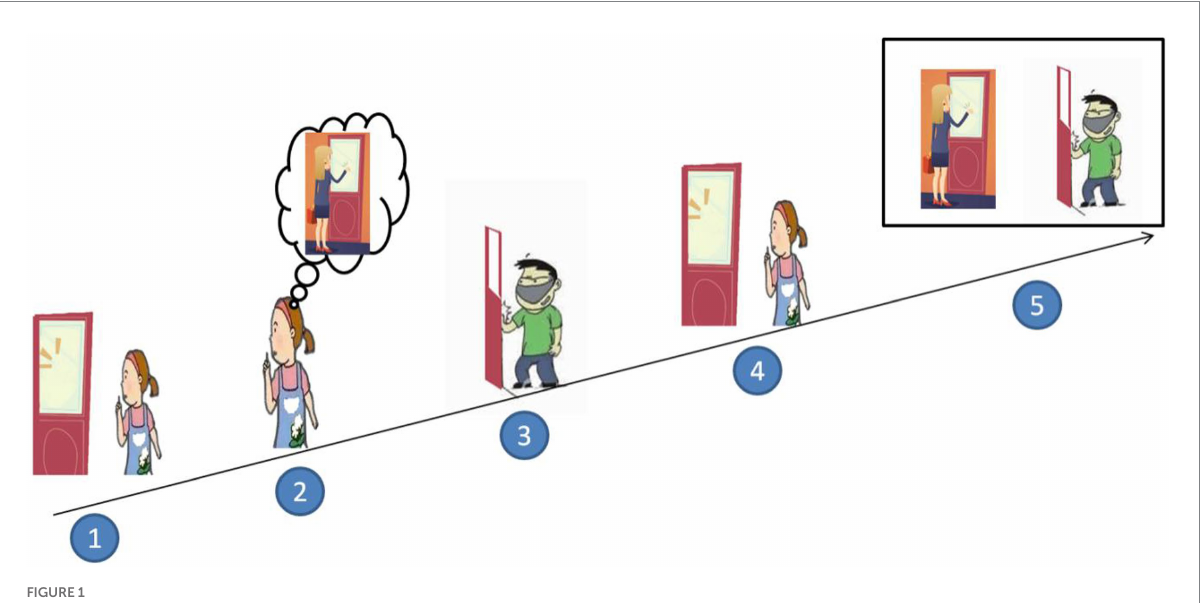
FIGURE 1 Example of sentential complement